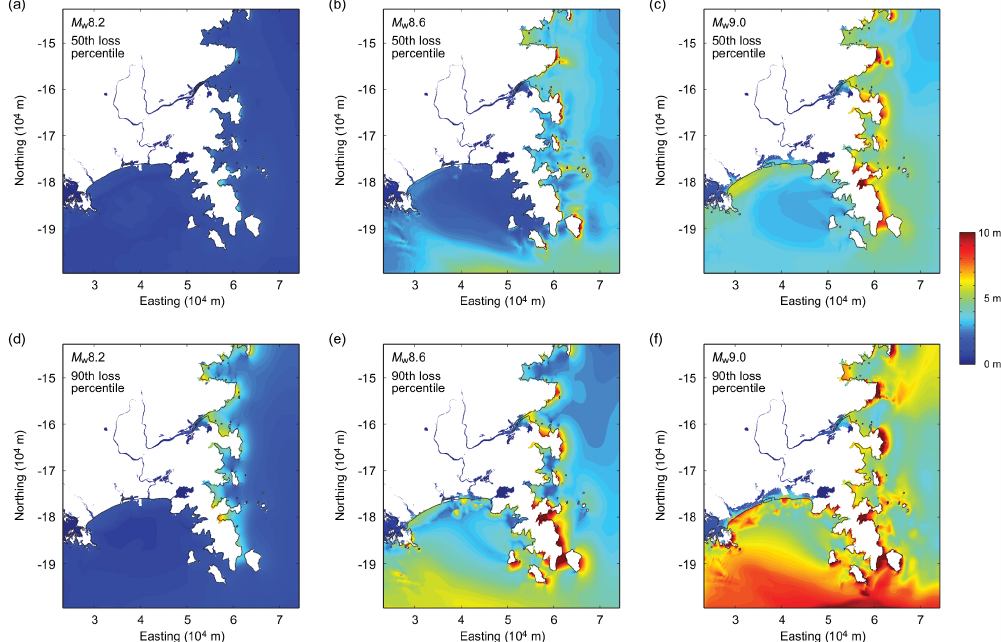
Figure 12. Inundation height maps in Ishinomaki–Minamisanriku areas corresponding to critical loss scenarios: (a) 50th loss percentile for M w 8.2, (b) 50th loss percentile for M w 8.6, (c) 50th loss percentile for M w 9.0, (d) 90th loss percentile for M w 8.0, (e) 90th loss percentile for M w 8.6, (f) 90th loss percentile for M w 9.0. The inundation height maps are shown in the Japanese plane orthogonal coordinate